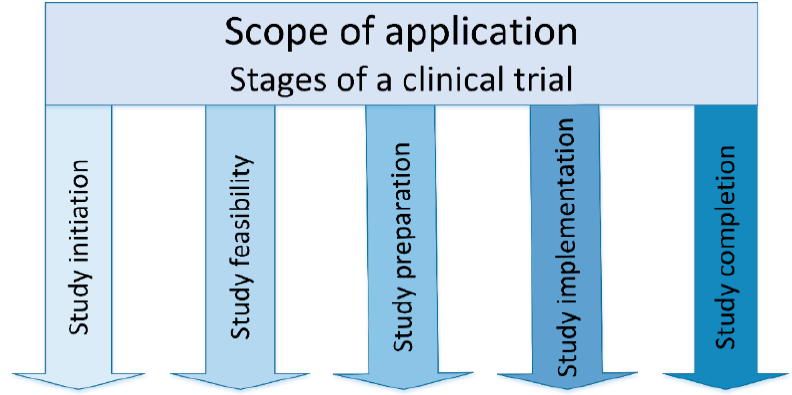
Figure 1. RDPS scope of application—study stages.